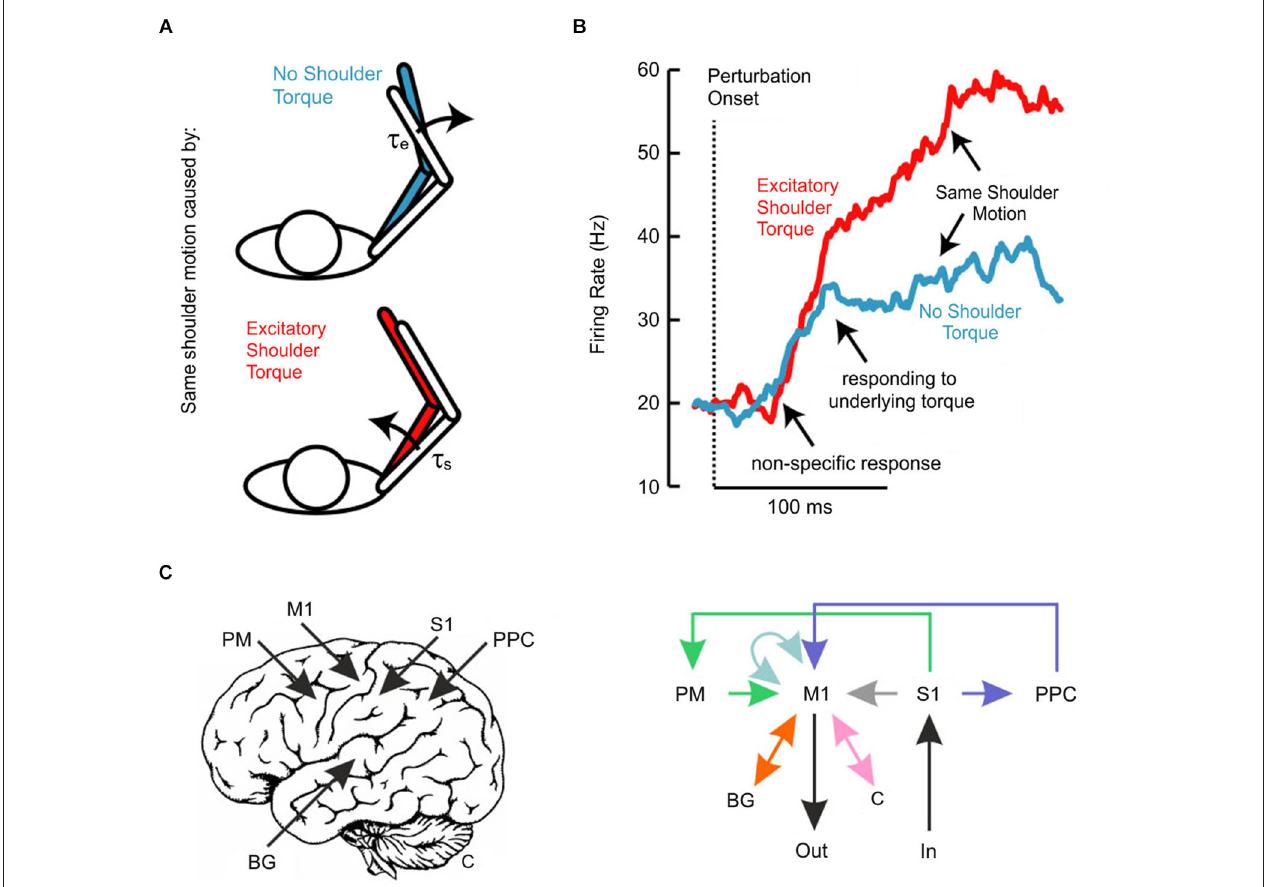
differentiation does not emerge until ∼ 50 ms post-perturbation. (C) Schematic representation of the neural pathways that likely contribute to the long-latency response in primary motor cortex. Deciphering which of these circuits contributes under which circumstances is an important outstanding question. Panels (A) and (B) modified with permission from Pruszynski et al.